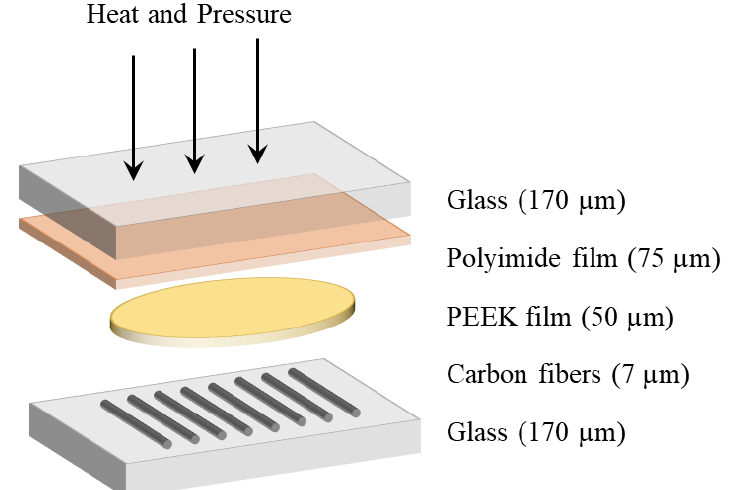
Figure 2. Sample stack-up used to produce thin PEEK samples with heat and pressure in a DMA.